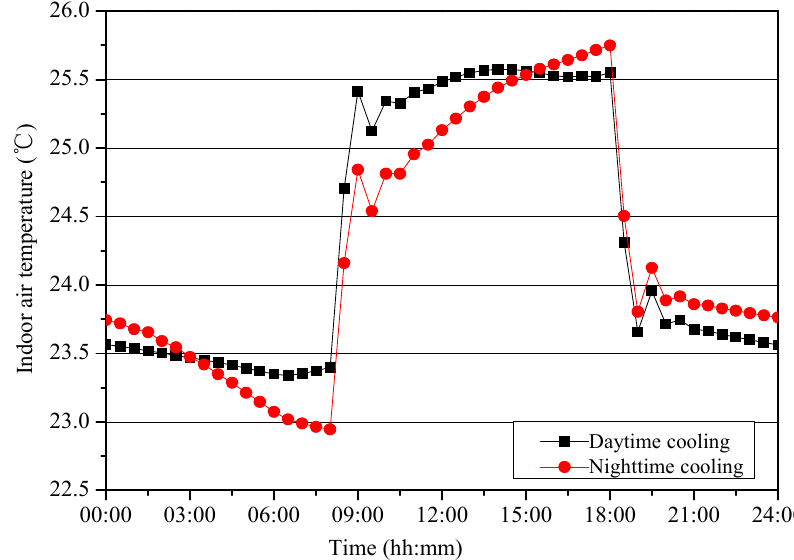
Figure 8. Indoor air temperature variation trends under daytime cooling and nighttime cooling during a typical day.